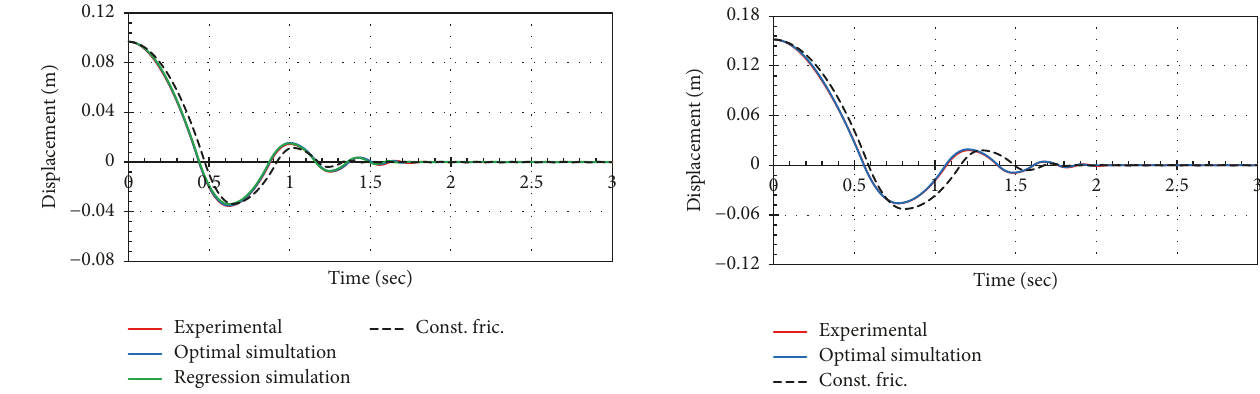
Figure 15: Simulation time history of displacement for the friction functionofmeasuringdisplacementandindividualbestfitandover- all best fitting function (WD40 whipped with initial displacement of 96.87 mm).